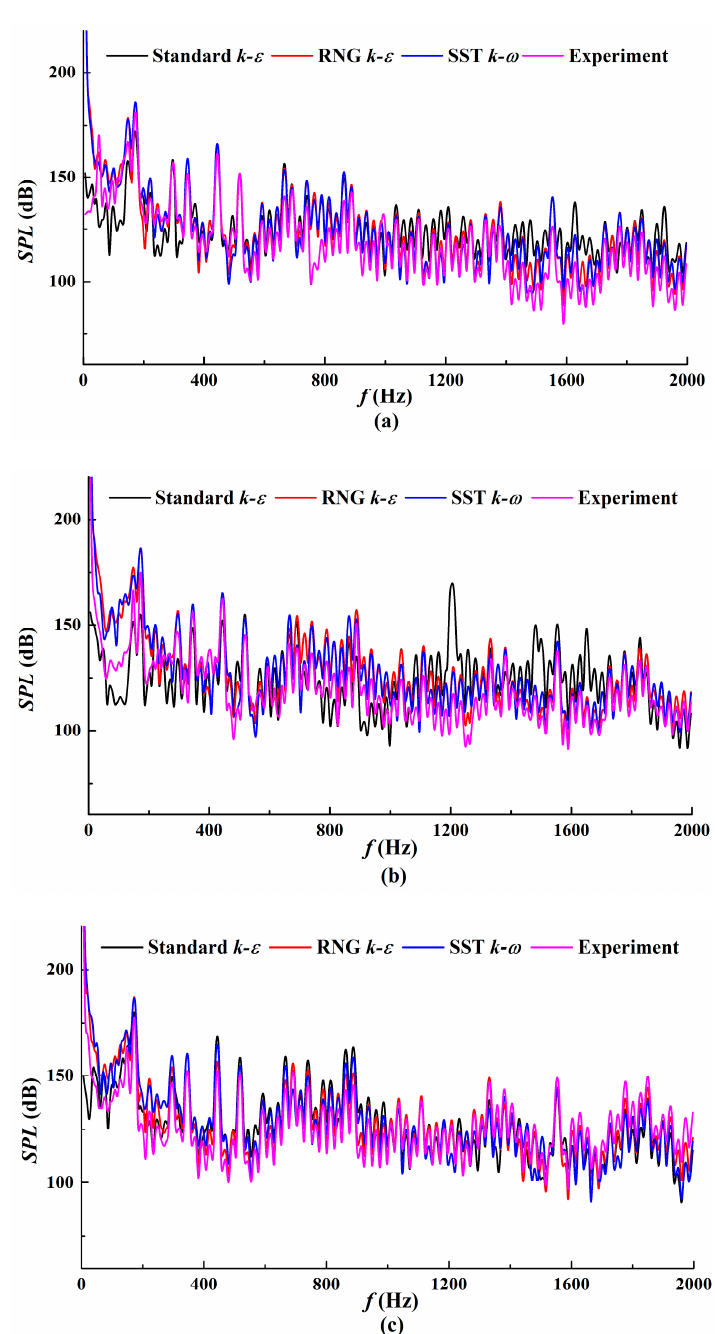
Figure 14. Sound pressure level SPL at the suction section for ( a ) 0.8 Q d , ( b ) 1.0 Q d , and ( c ) 1.2 Q d